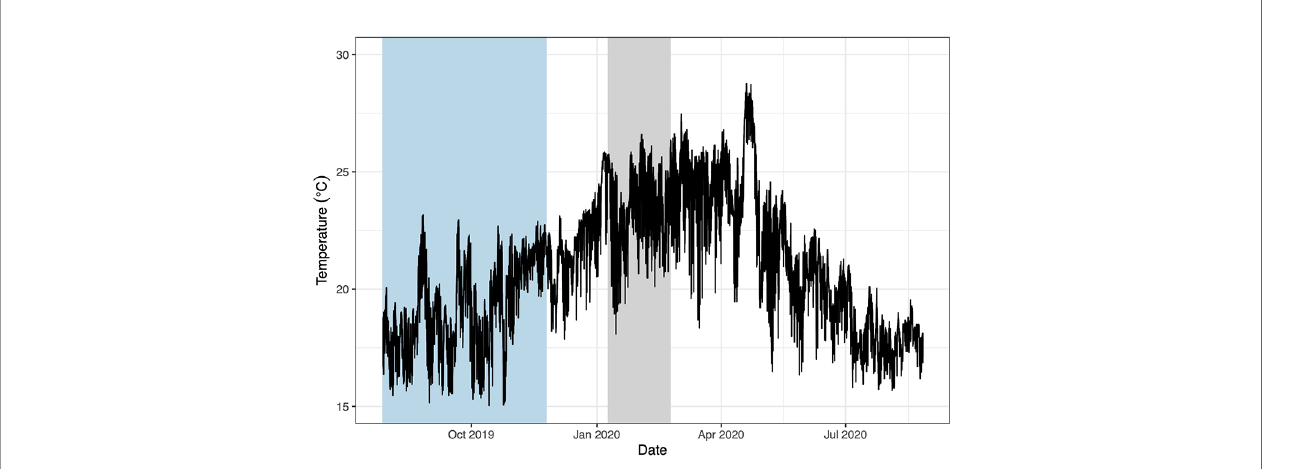
FIGURE 3 | Temporal variation on temperature on the surface of a nearshore rocky reef where our experiments were performed ( “ Cerro Mundo ” , 10 m depth at high tide) off the southeastern coast of San Cristo ́ bal Island, Gala ́ pagos. Data were recorded with HOBO Water Pro v2 Temperature Loggers (Onset Computer Corporation, Pocasset, MA). Measurements were taken every 15 min. Min: 15.0°C, Max: 28.7°C, Mean: 21.0°C. The blue bar highlights the temperatures during the cool season experiment and the gray bar during the warm season